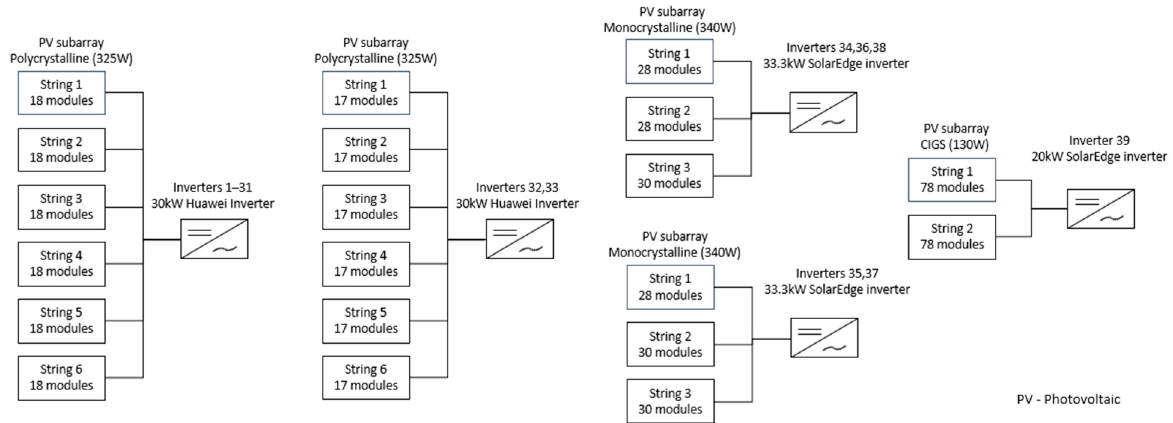
Figure 2. Simplified block diagram of photovoltaic power plant in University of Louisiana, Lafayette. AC power from the 39 inverters is combined in five high voltage panels (HP). Each 35 A, 50 A, or 60 A breaker in the HP panels can trip one inverter at a time, as shown in Figure 3. Two distribution panels (DP) combine the power from the five high voltage pan- els, and each 400 A DP breaker can trip eight inverters at a time for maintenance. The energy passes through 11 kV/400–230 V/1000 kVA transformer. The power from the trans- former goes through 11.2 kV lines and reaches the Reinhardt substation for supplying the power to the university.